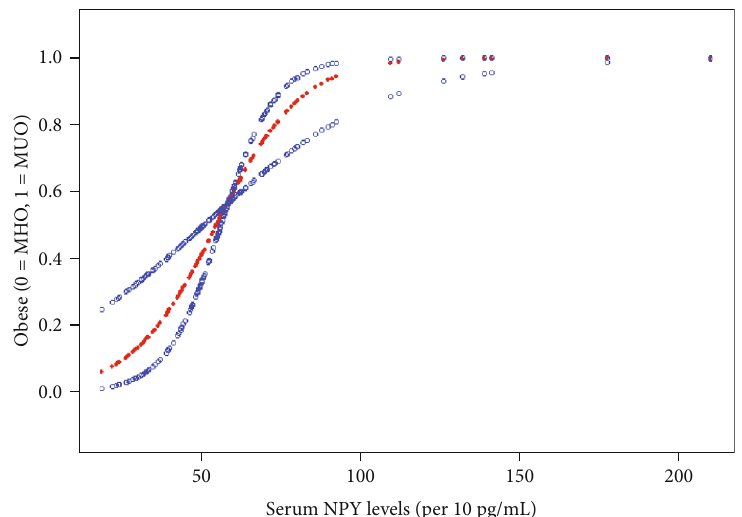
Figure 1: The curved lines illustrate the relationship between the serum NPY levels and MUO. A threshold and nonlinear association between serum NPY levels (per 10 pg/mL increment) and MUO was found ( p = 0 : 001 ). The area between the two dotted lines represents the 95% CI. The blue bands represent the 95% CI for the smoothed curve fi t, and the red line represents the smoothed curve fi t between the variables. The model was adjusted for sex, age, BMI, WC, WHR, TC, LDL-C, and HbA1c. Table 5: Analysis of the threshold e ff ect of NPY on MUO. In fl ection point of